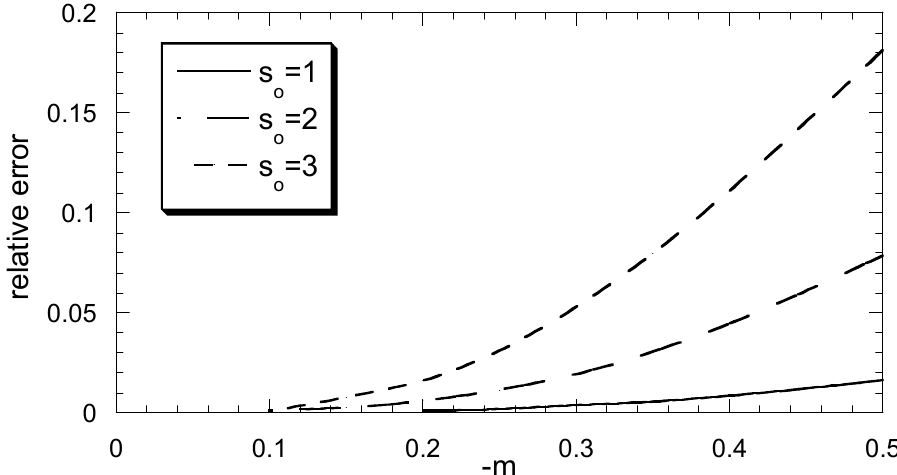
Figure 1. Relative error of the method of moment in computation of M 1 (in time such that the exact value of M 1 is 0.1) versus exponent m for three values of the initial dispersity s o .